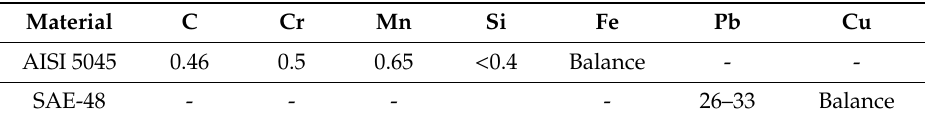
Table 1. Chemical composition of specimens (wt.%).